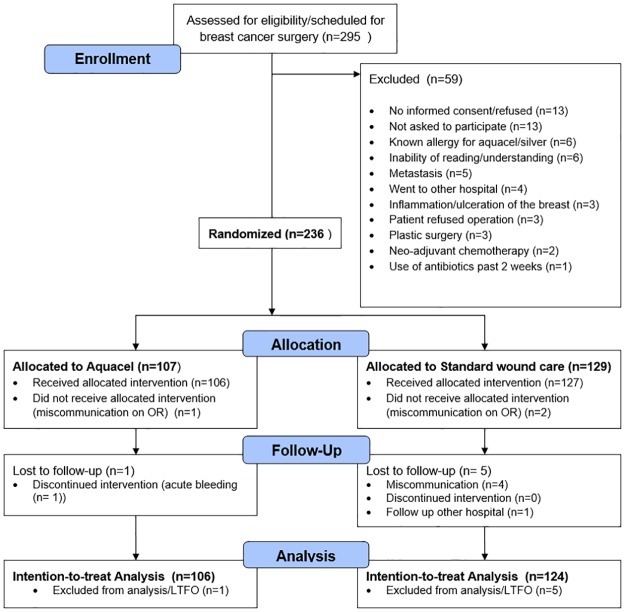
CDC criteria for an SSI [14,22].aDiagnosis of ‘cellulitis’ alone does not meet criterion 4 since 2010, but this change underestimates the infection rate and is not recommended to be used by Degnim [5].